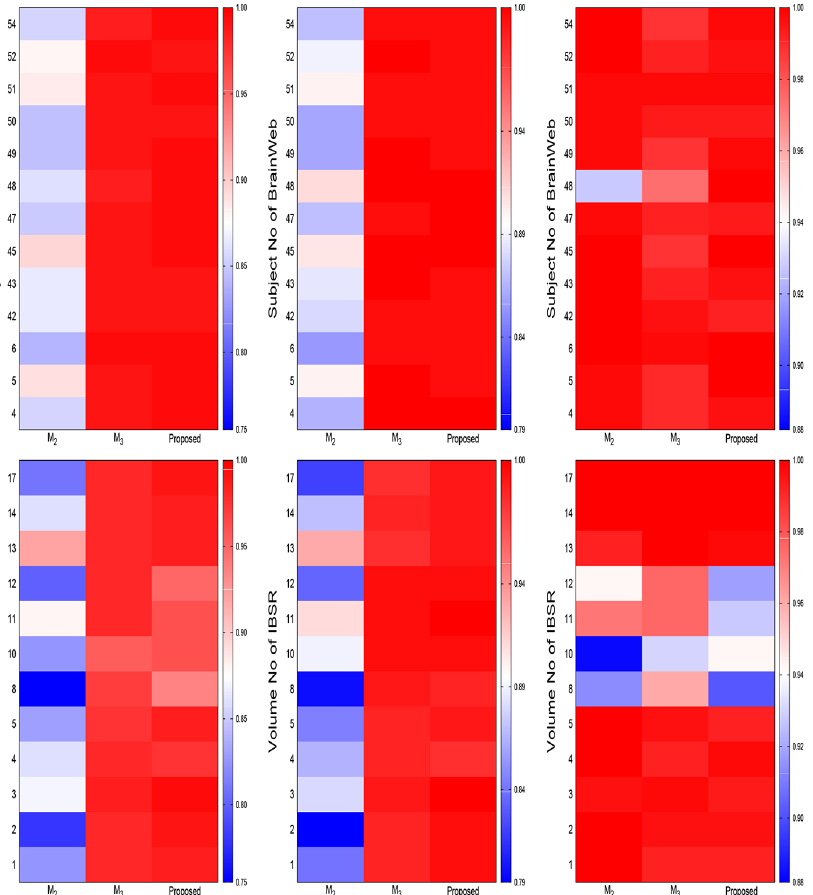
Fig 12. Heat maps for comparative performance analysis of the proposed method (skull stripping), the method M 2 (without skull stripping), and the method M 3 (masking using BET) for background separation (from left to right: Jaccard index, sensitivity, and